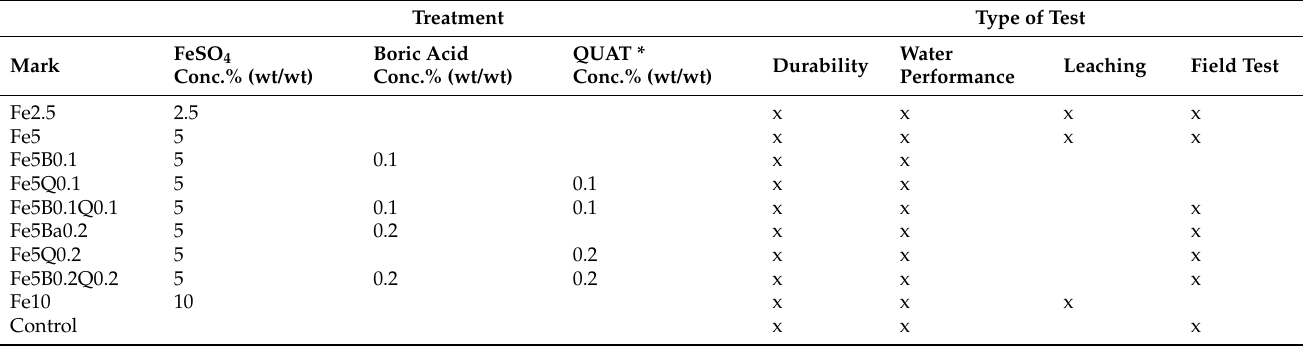
Table 1. Experimental